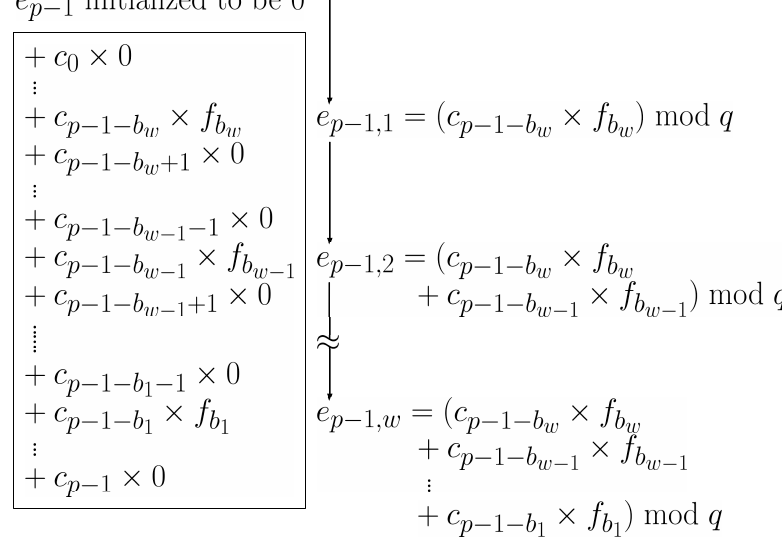
Figure 1: The Internal States of e p −